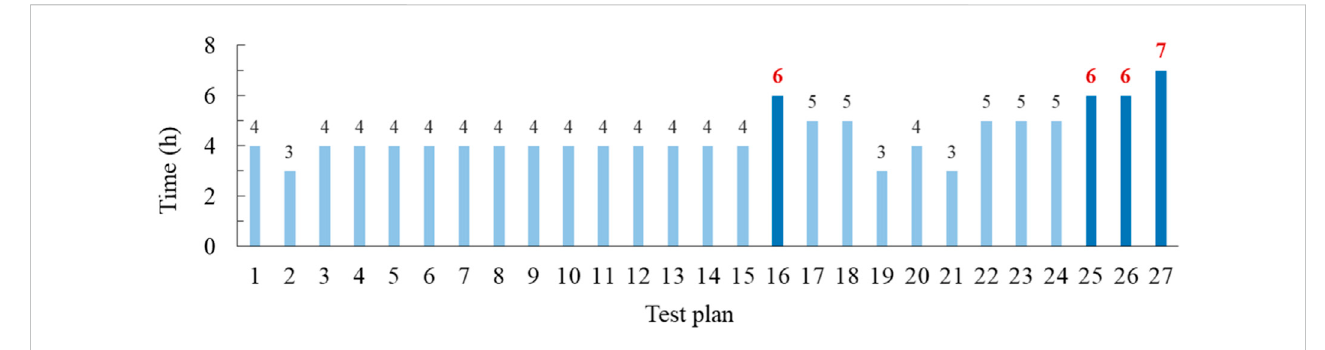
FIGURE 7 Total duration of each test scheme in thermal comfort range in summer.